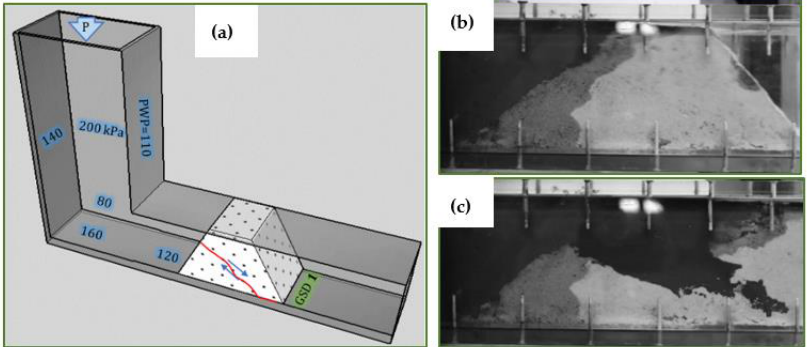
Figure 15. The failure mechanism of a waste rock barricade made of GSD #1: ( a ) the different pressure values in the model at failure, ( b ) the barricade before the failure (the top largely moved), and ( c ) the barricade after the collapse .